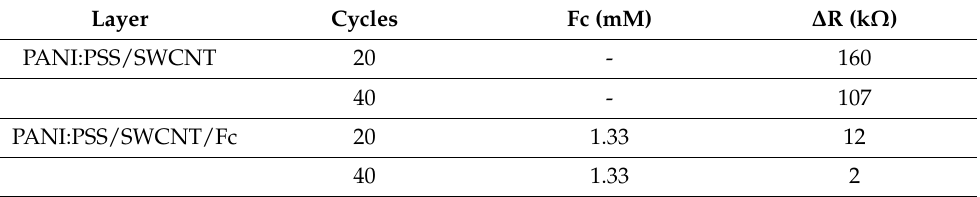
Table 5. ∆ R values for PANI:PSS/SWCNT and PANI:PSS/SWCNT/Fc at 20 and 40 CV cycles. Layer